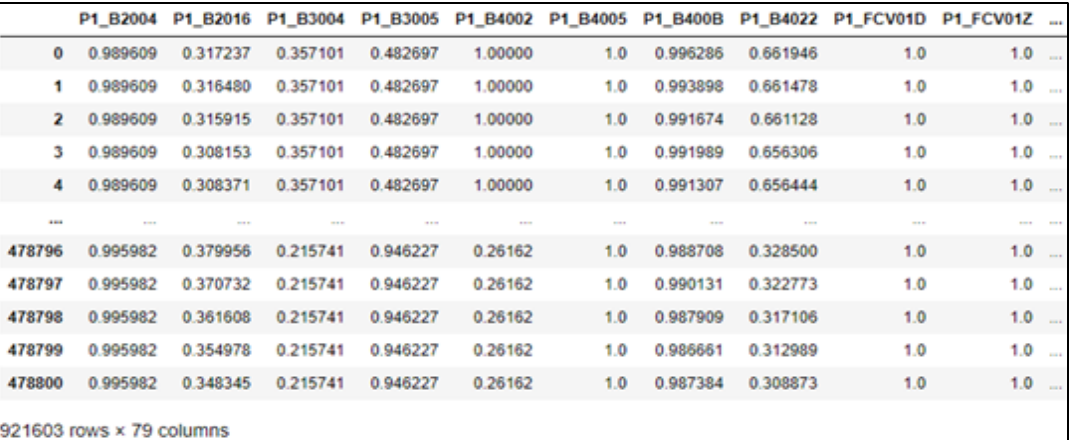
Figure 6. Normalized training data. The third step removes unnecessary data points using the feature graph. After nor- malizing the data points of the training data and converting them to values between 0 and 1, we used the graph to study the characteristics of the data